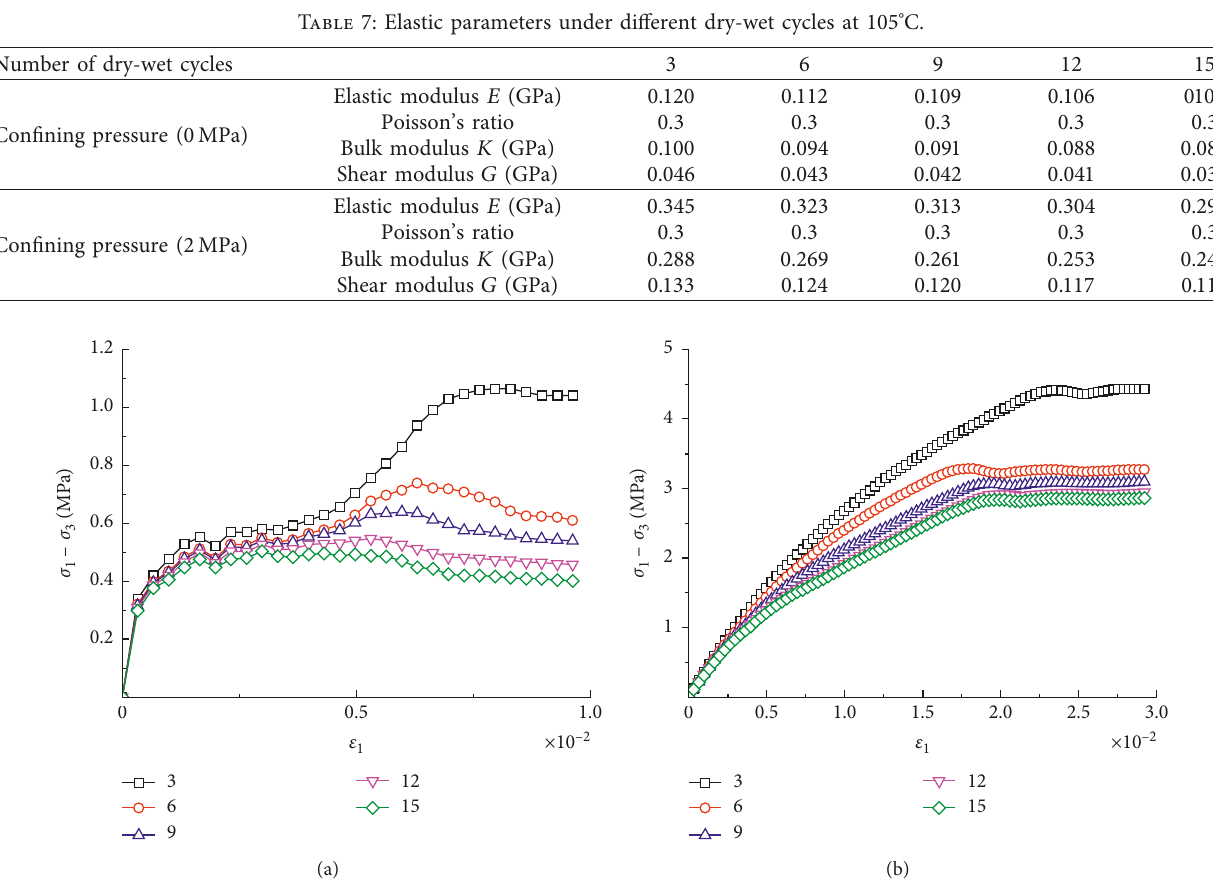
Figure 6: Stress-strain curve under different dry-wet cycles: (a)